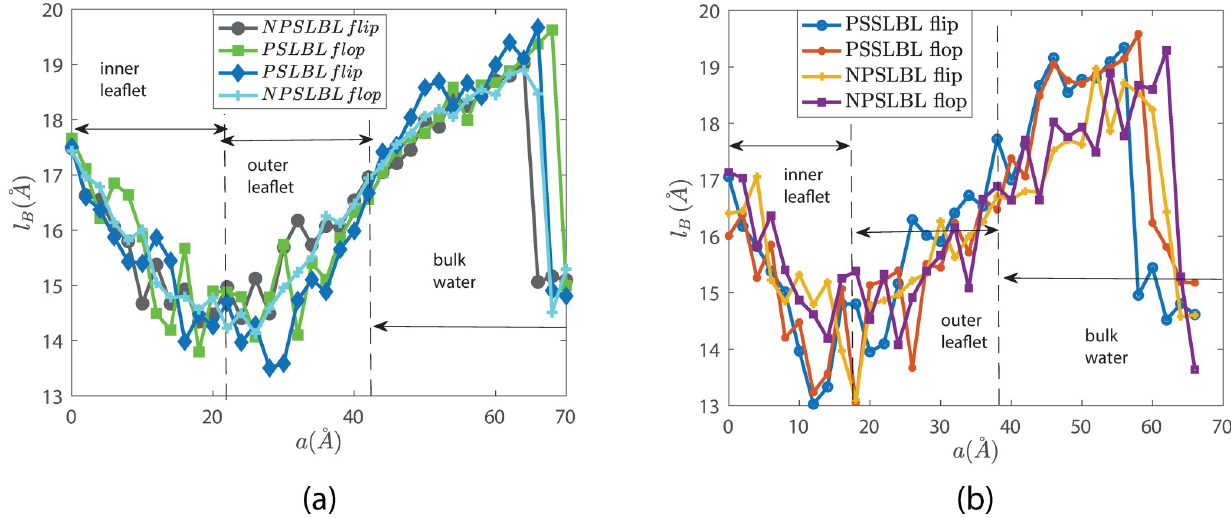
Fig 6. Variation of the tail length l for the star lipid molecules traversing inside and outside the LBL for the NPSLBL and the PSSLBL. l B defined in Fig 1(a) and its caption. Results are shown for systems A (NPSLBL with NP composed of Nda beads) and C (PSSLBL with the planar support composed of Nda beads) in part (a) and for systems B (NPSLBL with NP composed of P5 beads) and D (PSSLBL with the planar support composed of P5 beads) in part (b). Also, in both (a) and (b), we identify the locations of the lipid bilayer and the bulk water. Furthermore, a = 0 Å represents the location of the inner leaflet for both the NPSLBL and the